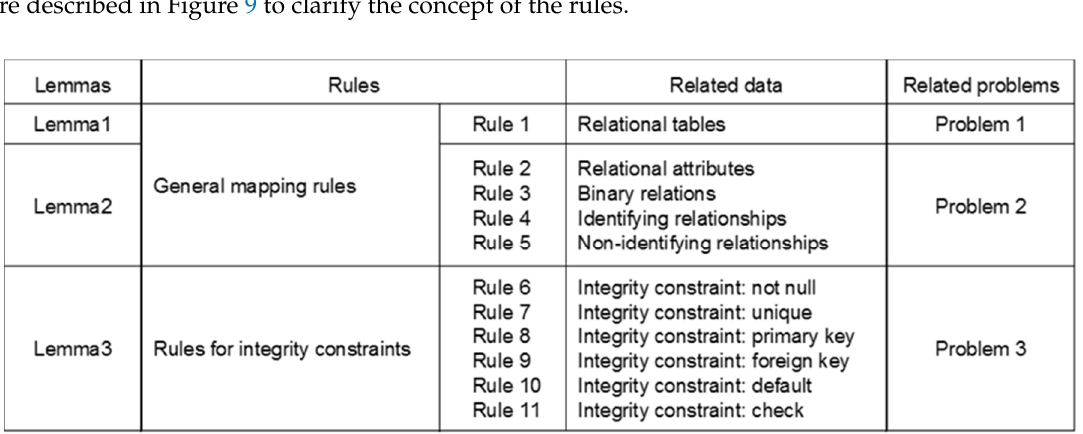
Figure 9. Relationships among the lemmas, rules, and problems.